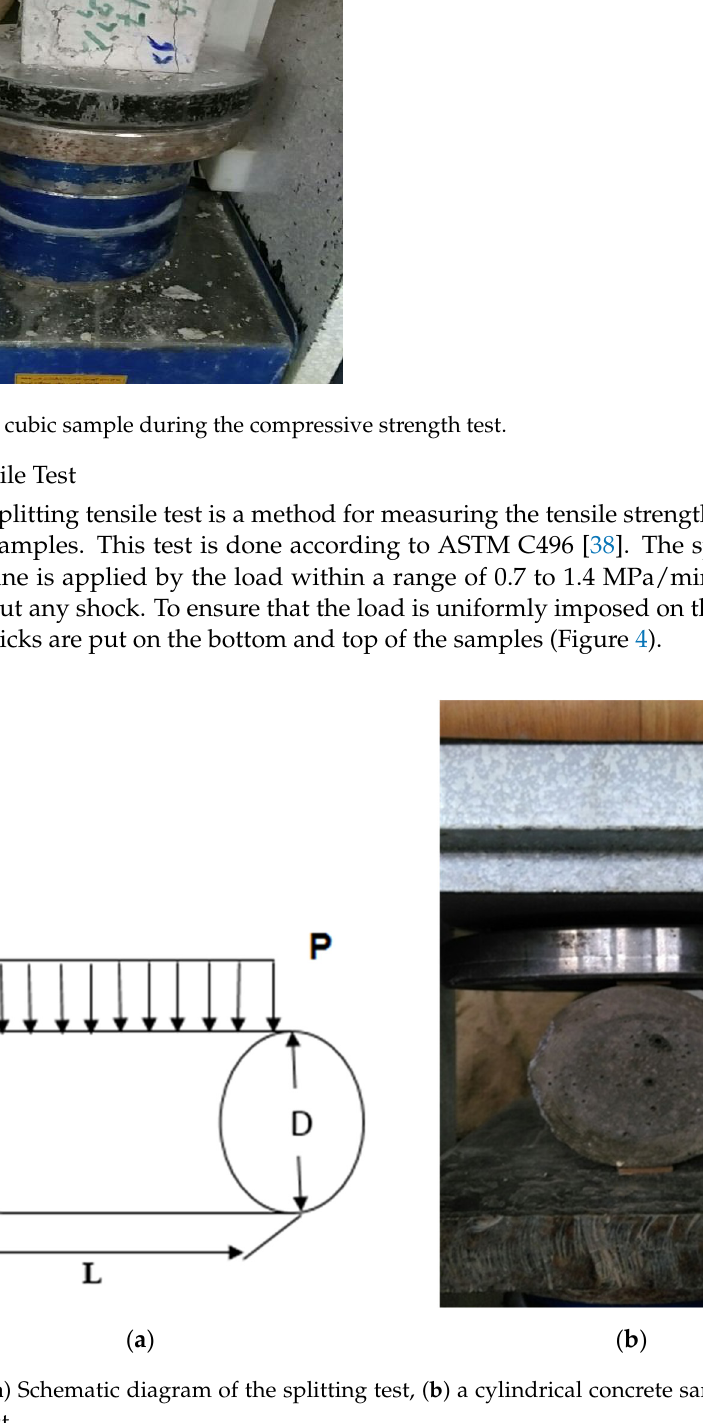
Figure 4. ( a ) Schematic diagram of the splitting test, ( b ) a cylindrical concrete sample during the splitting